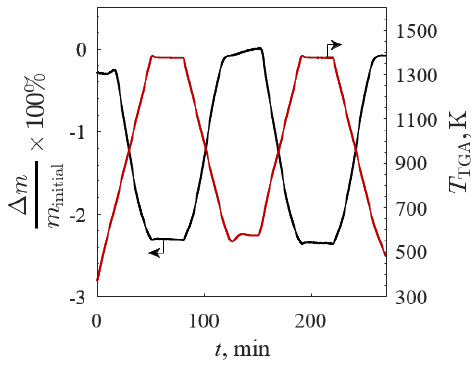
Figure 7. Relative mass change (black line) and temperature (red line) versus time of Ba 0.2 Sr 0.8 FeO 3 − δ between 573 and 1373 K in 20% O 2 /Ar for TGA Screening 1.